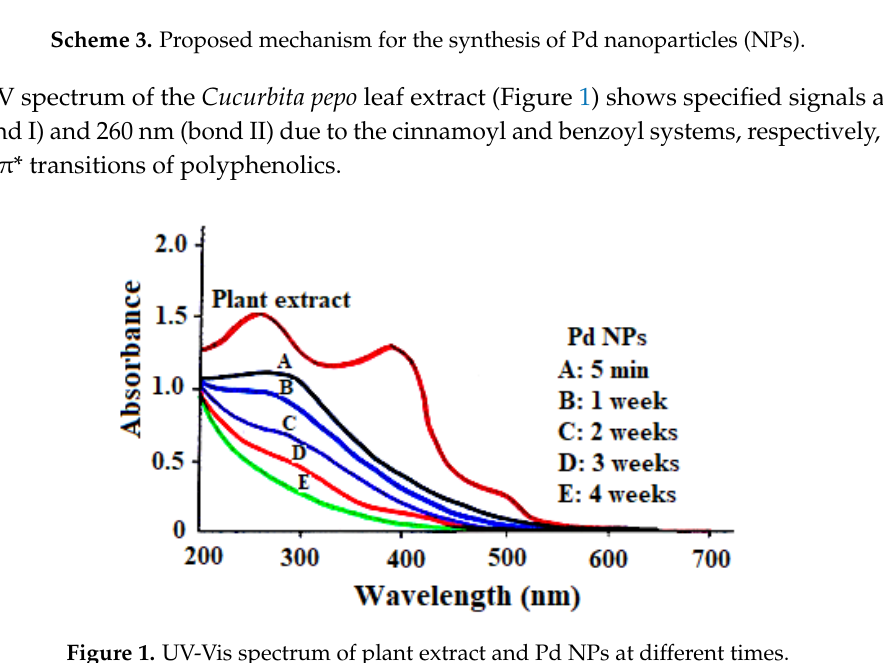
Figure 2. FT-IR spectrum of Pd NPs. The XRD pattern of synthesized Pd NPs (Figure 3) exhibited a crystalline structure for the sample with peaks at 40.13° (111), 46.4° (200) and 66.5° (220), which precisely pertain to the signals of Pd NPs as corroborated by previous reports [61].